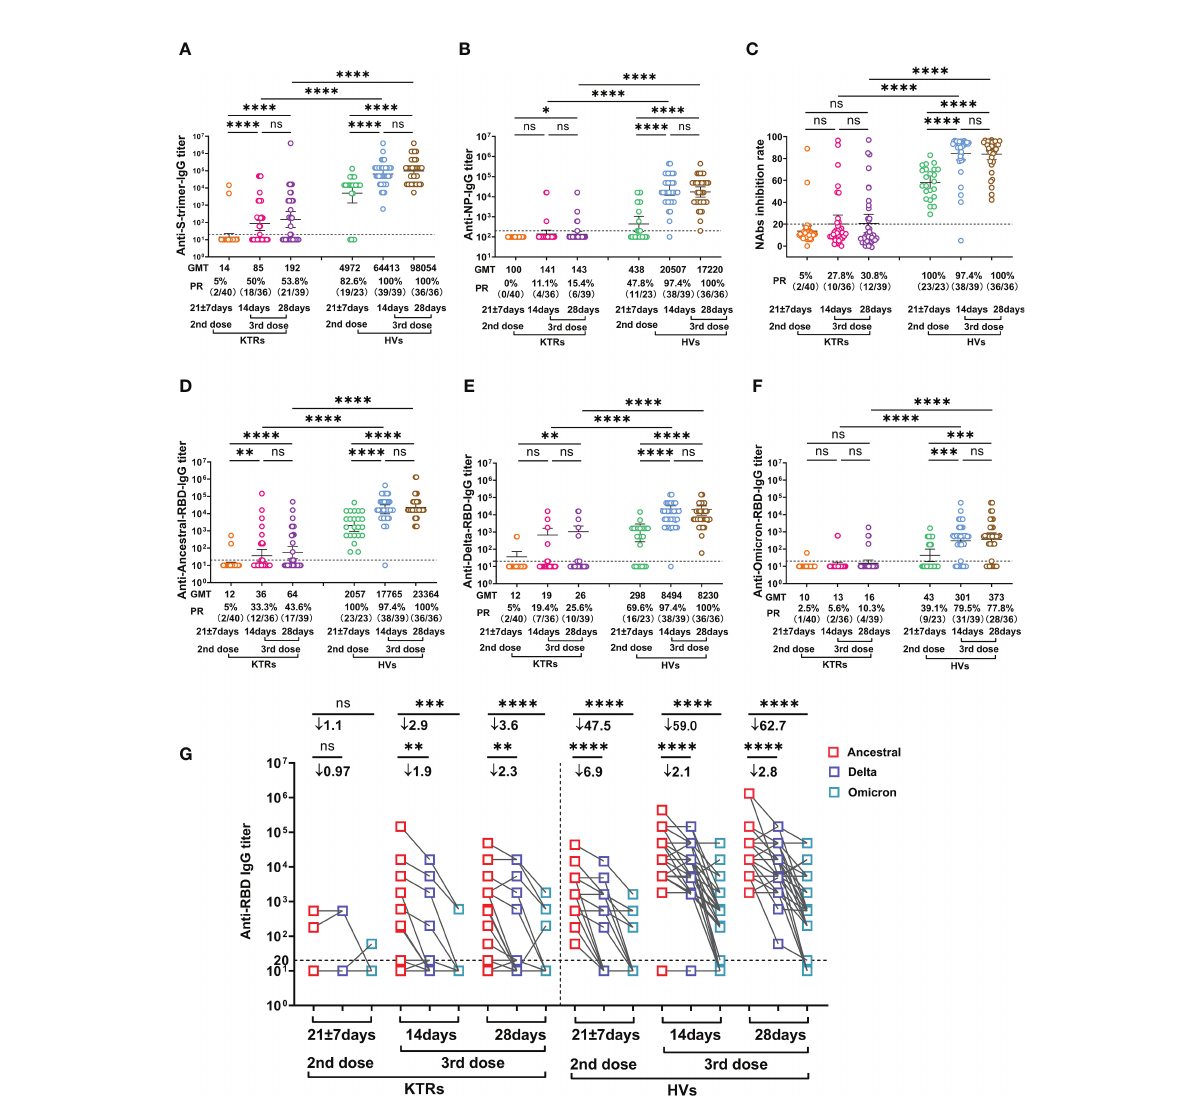
FIGURE 1 Comparative analysis of SARS-CoV-2 speci fi c antibody IgG between kidney transplant recipients (KTRs) and healthy volunteers (HVs) after the second and third homologous booster. (A, B) anti-Ancestral-Spike (S) -trimer-IgG (A) and anti-Ancestral nucleocapsid protein (NP)-IgG (B) titers in KTRs and HVs 14-28 days after the second vaccination with inactivated vaccine and 14 and 28 days after the third homologous booster. (C) Neutralizing antibodies (NAbs) inhibition rate measured by surrogate virus neutralization test in KTRs and HVs 21 ± 7 days post second vaccination with inactivated vaccine and 14 and 28 days after the third homologous booster. (D-F) Anti-Ancestral- (D) , anti-Delta- (E) , anti- Omicron-RBD (F) IgG titer in KTRs and HVs 14-28 days after the second vaccination with inactivated vaccine and 14 and 28 days post third homologous booster. (G) Paired analysis of Anti-Ancestral-, anti-Delta- and anti-Omicron-RBD IgG titer in KTRs and HVs 14-28 days post second vaccination with inactivated vaccine and 14 and 28 days post third homologous booster. Bar: geometric mean titers (GMT) and 95% con fi dence interval; dotted line: the detection limits; PR: positive rate. Statistical differences were determined by Mann-Whitney U test. P-values were indicated by ns, not signi fi cant (P > 0.05), * (p < 0.05), ** (p < 0.01), *** (p < 0.001), and **** (p <